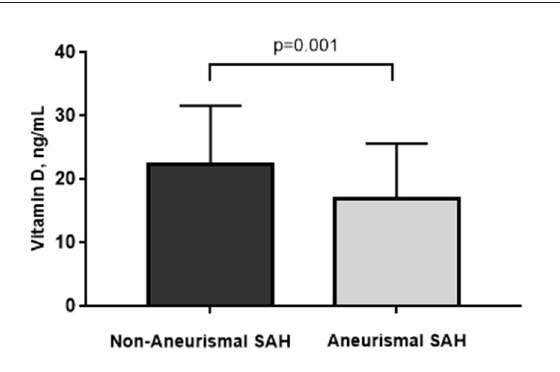
FIGURE1 Vitamin D levels were significantly lower in the aneurysmal SAH group than in the non-aneurysmal SAH group (16.95 ± 8.69 vs. 22.74 ± 9.12ng/ml, p =